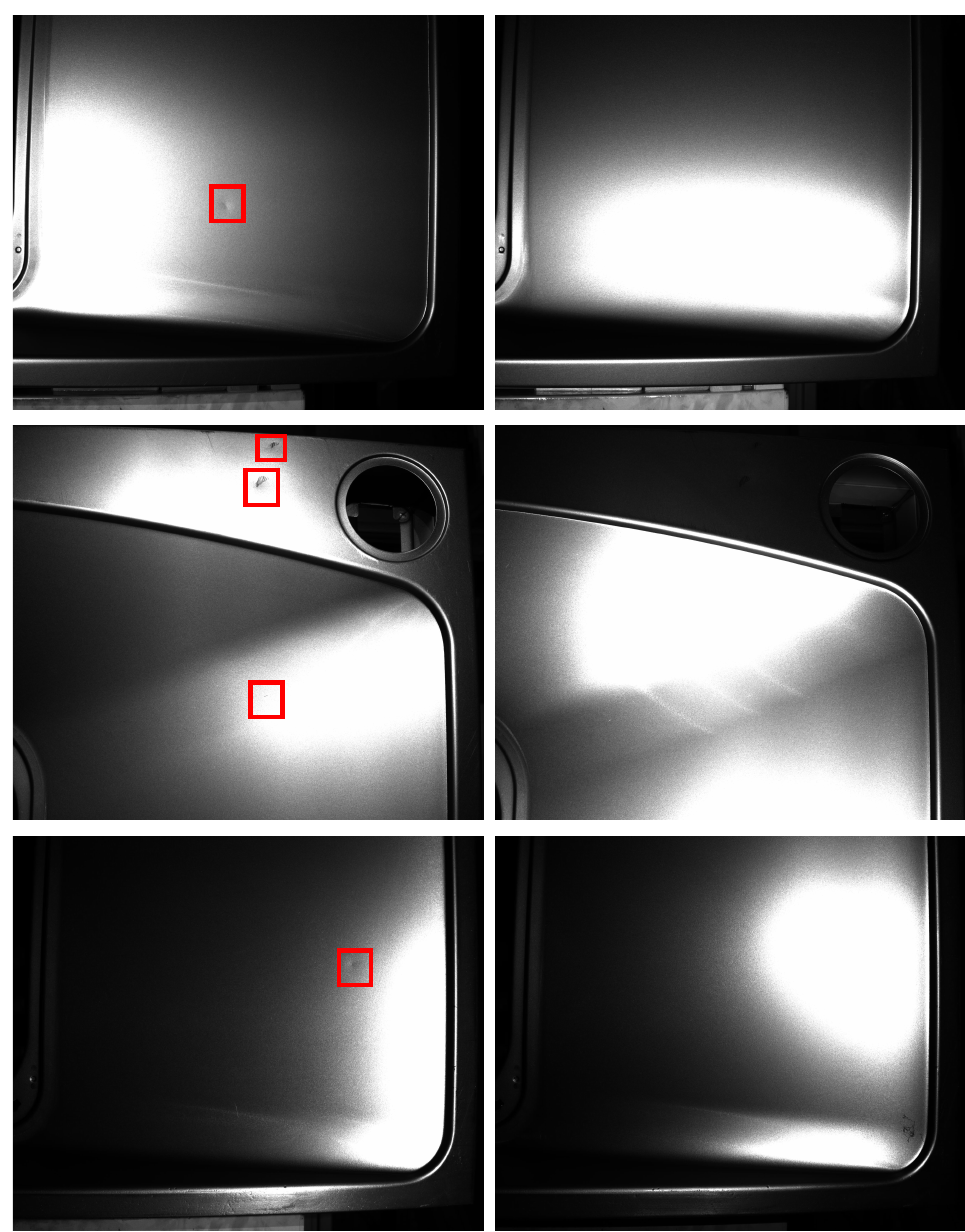
Figure 1. Images of stationary metal objects under different lighting conditions. Each row represents images of an object captured under different directional light. The red box indicates the location of the defect. ( Left ): defect visible. ( Right ): defect in overexposed or shadow area. When the angular bisector of the incident light and the view coincide with the normal vector, the observation points appear glossy. The surface prevents the light from falling on itself, which leads to the attached shadow in the observation area. When the surface prevents the light from falling on another surface, the observation are appears with a cast shadow [7]. However, as the shape of the object is unknown, the way to avoid